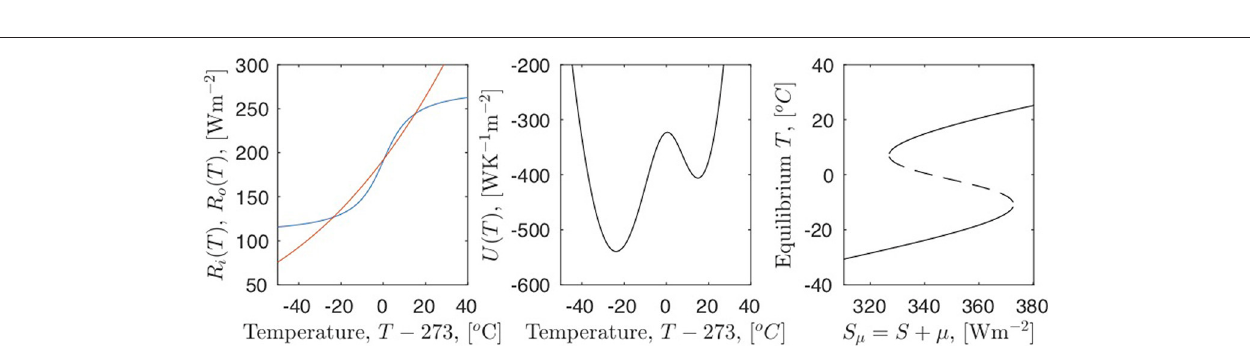
FIGURE 2 | The global energy balance model. The left panel shows incoming radiation, R i ( T ), in blue and the outgoing radiation R o ( T ) in red. There are three steady state points; two stable separated by an unstable. The middle panel shows the equivalent “climate potential" as a double well potential. The right panel shows the bifurcation diagram obtained by changing the insolation S µ = S + µ . The stable cold and warm states (solid lines) are connected at two saddle-node bifurcations via an unstable steady state branch (dashed line).